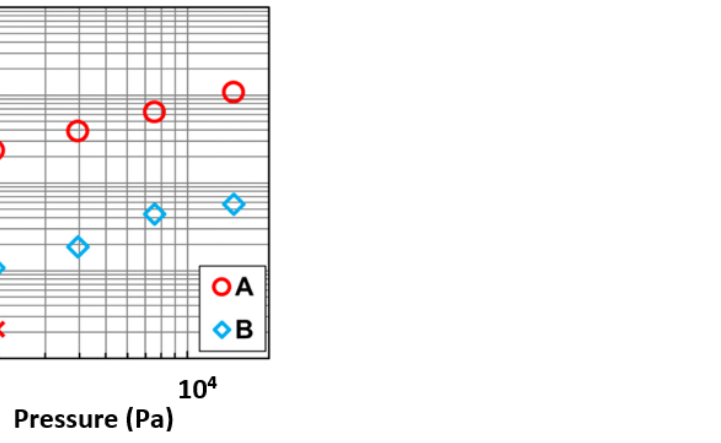
Figure 5. CO concentration as a function of Ar gas pressure. Monitor points A and B correspond to those in Figure 2. The cross indicates the measured concentration obtained without the Si melt and with a quartz crucible at A Reproduced with permission from Y. Miyamura, H. Harada, X. Liu, S. Nakano, S. Nishizawa, K. Kakimoto, Journal of Crystal Growth; published by Elsevier, 2019 [8].